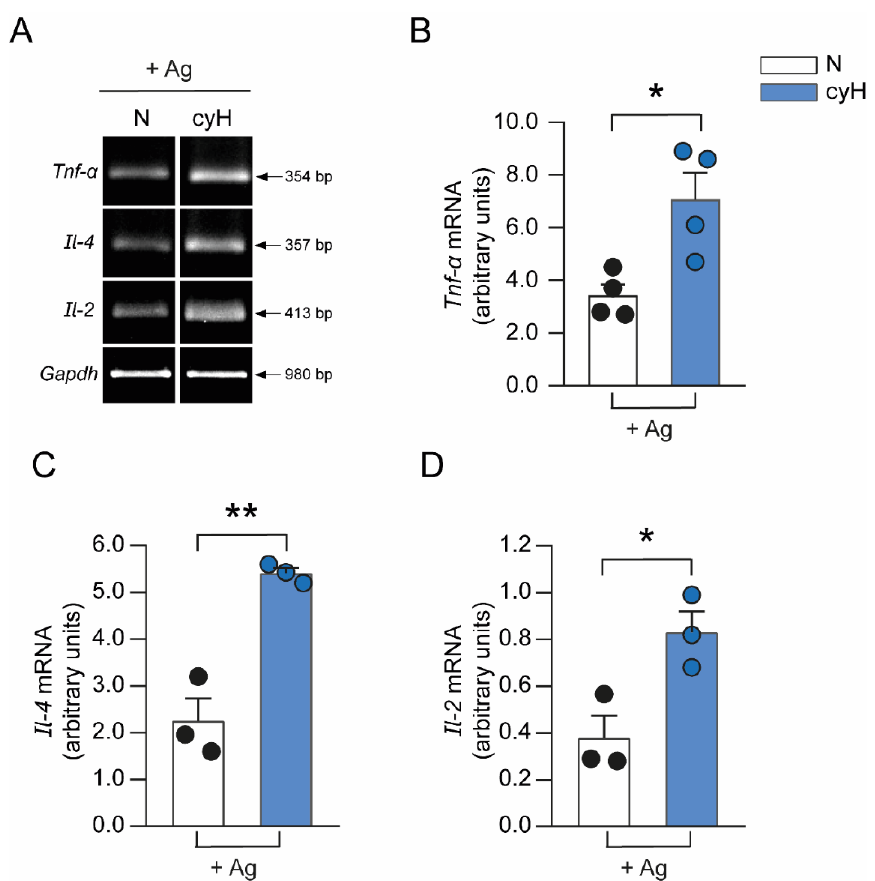
Figure 5. Cyclic hypoxia induces increased mRNA levels of cytokines related to Ca 2+ signaling in antigen-activated BMMCs. Two million BMMCs were incubated in N (2.5 h at 21% O 2 , N) or cyH (H2) and sensitized with 100 ng/mL IgE 1 h before the end of the cyH protocol. Normoxic or hypoxic IgE-sensitized BMMCs were then stimulated with the specific Ag DNP-HSA (9 ng/mL) for 2 h. Total mRNA was purified to analyze the expression of Ca 2+ signaling- related cytokines by RT - PCR. ( A ) Representative images of an agarose gel show ing amplification of the indicated cytokines. ( B – D ) Bar graphs showing densitometric analysis of Tnf- α , Il-4, and Il-2 amplicons obtained from normoxic and hypoxic BMMCs after challenge with IgE/Ag. Gapdh expression was used as a housekeeping gene. Bar graphs of N and cyH show the fold-change relative to values obtained without Ag stimu- lation (basal). Unpaired t -test, * p < 0.05, and ** p < 0.01 versus N, n = 3–4 experiments for each